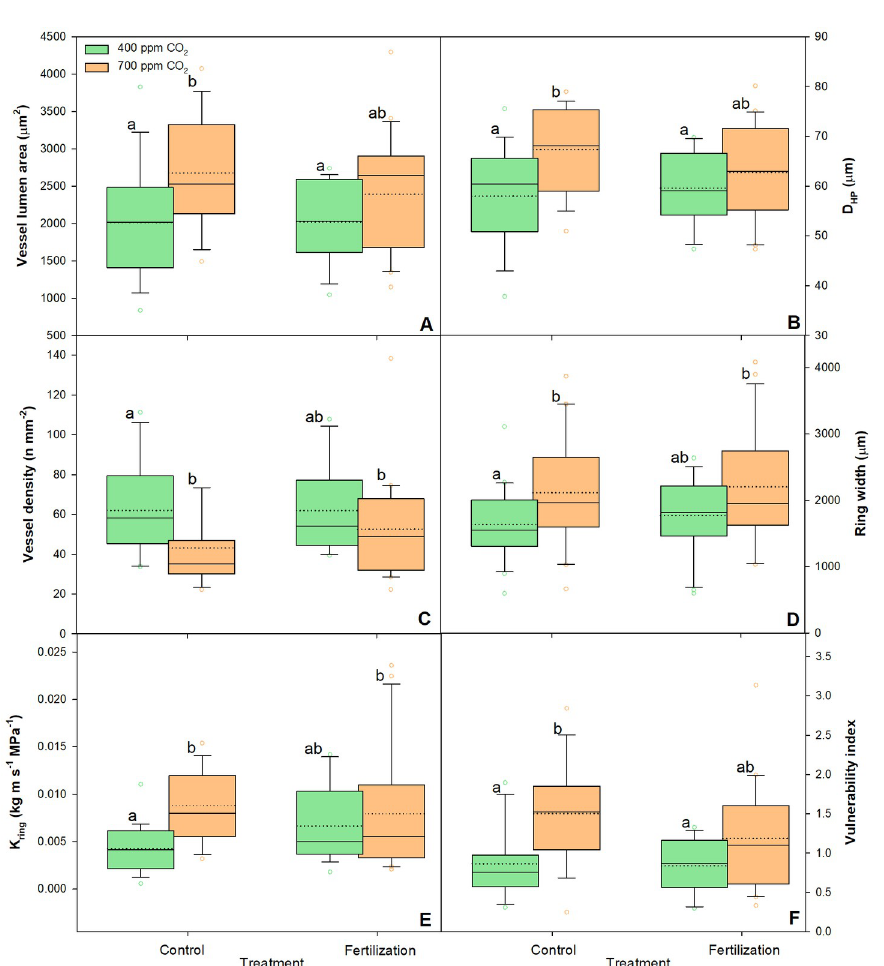
Fig 5. Changes in vessel lumen area (A), D HP (B), vessel density (C), Ring width (D), K ring (E), and Vulnerability index (F) of sessile oak saplings (n = 18) treated under ambient (400 ppm CO 2 ) and elevated (700 ppm CO 2 ) and different nutrient supplies. The data are expressed as medians (solid lines) and means (dotted lines) of measurements. The box boundaries mark the 25 th and 75 th percentiles and whiskers the 10 th and 90 th percentiles. Circles mark outliners. Different letters indicate significant differences (p � 0.05) estimated on the base of Duncan’s ANOVA post-hoc test.